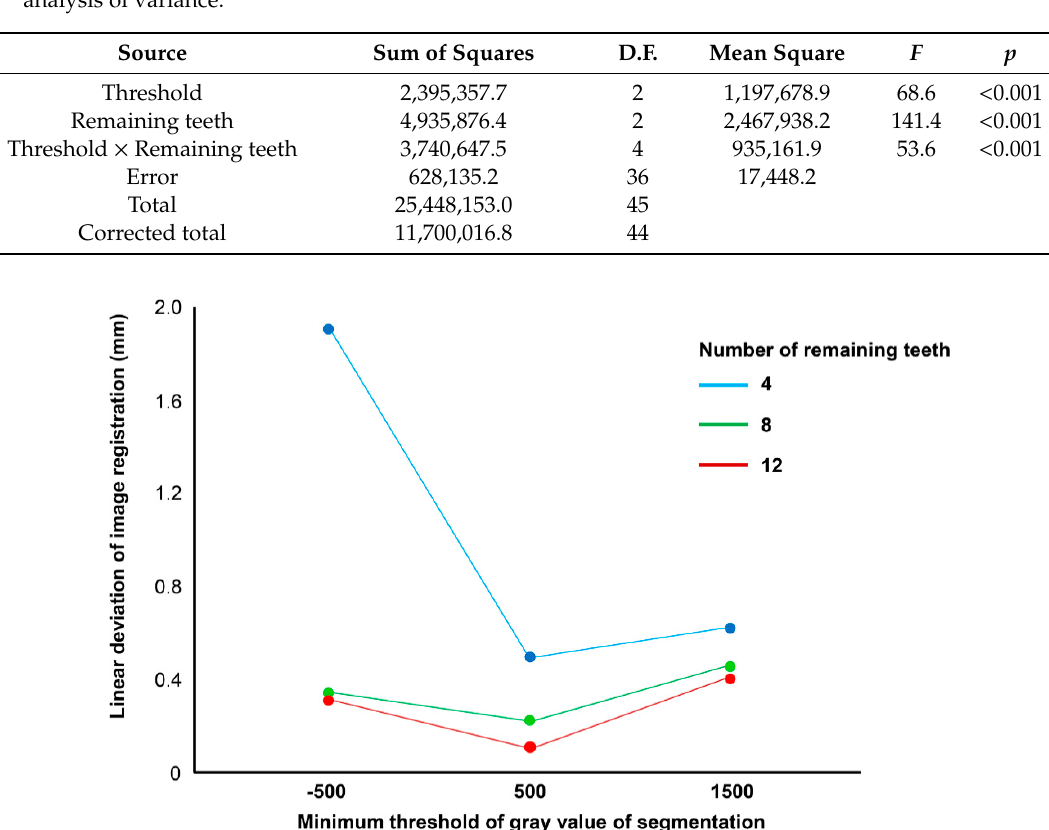
Figure 6. Line graph showing the effect of the threshold of gray value of segmentation on the image registration error of the scan image to cone-beam computed tomography in the dental arch with different numbers of remaining teeth.